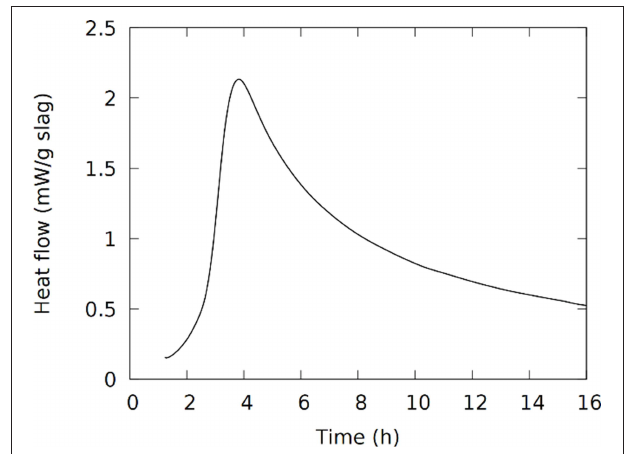
FIGURE 1 | Heat flow in isothermal calorimetry at 20 ◦ C from the first 16h after